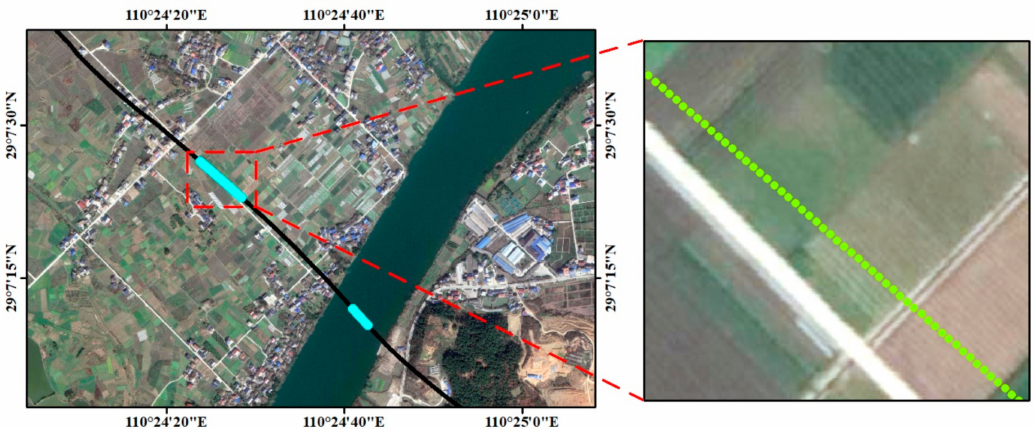
Figure 9. Example of lidar flight trajectory over unplanted wintertime